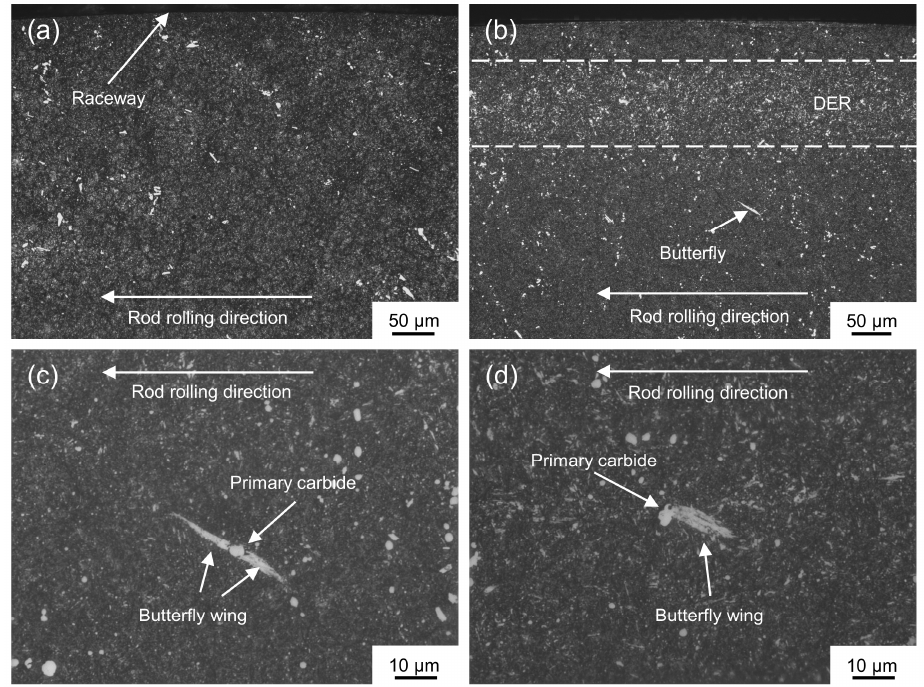
Figure 2. Optical micrograph of the radial cross-section of the center of the raceway of the RCF- tested samples: ( a ) optical micrograph of the RCF-tested sample under 5 GPa after 1.33 × 10 7 cycles; ( b ) optical micrograph of the RCF-tested sample under 5 GPa after 1.14 × 10 8 cycles; ( c ) optical micrograph of a butterfly with two wings ( P 0 = 5 GPa, N = 1.14 × 10 8 cycles); ( d ) optical micrograph of a butterfly with a single wing ( P 0 = 5 GPa, N = 1.14 × 10 8 cycles).